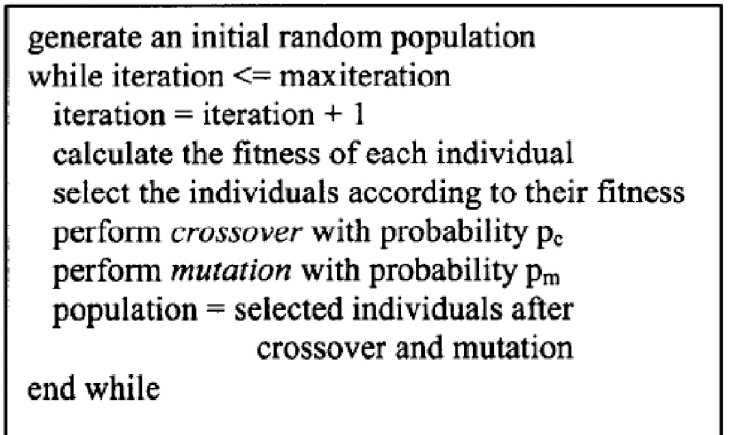
Fig 12. Basic genetic